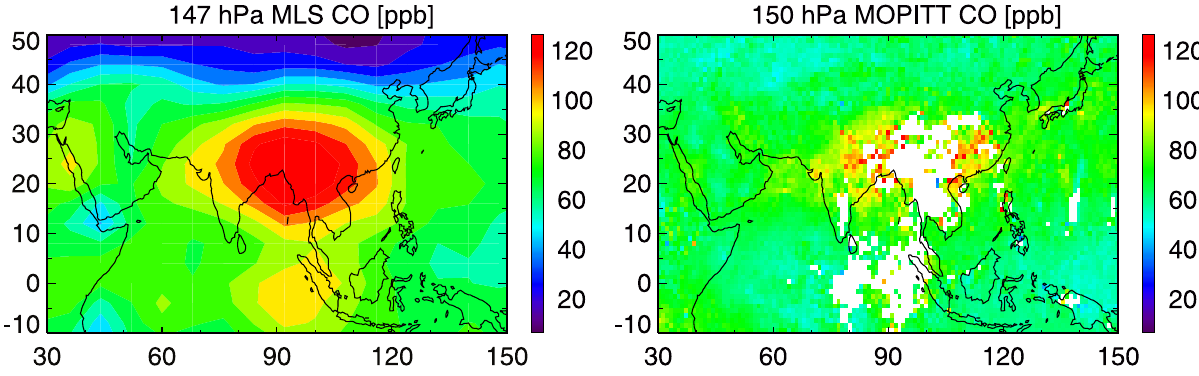
Fig. 44. Satellite observations of the mixing ratios of CO at 147hPa from the MLS satellite instrument and at 150hPa from the MOPITT Figure 1. Concentrations of CO at 147 hPa from MLS and satellite instrument (averages of both for the ten days that MLS measurements were available, on 25–27, 29–31 August and 3–6 Septem- ber 2004); white areas indicate missing data (from Li et al., 2005, copyright 2005 by the American Geophysical Union, reproduced with at 150 hPa from MOPITT. Values are averaged for the 10 MLS measurement days of 25 – 27, 29 – 31 August and 3 – 6 September 2004 (August 28 and September 1 – 2 are not retrieved because they either do not meet science team criteria or have not fit within MLS operational constraints). (right) White areas indicate missing data.